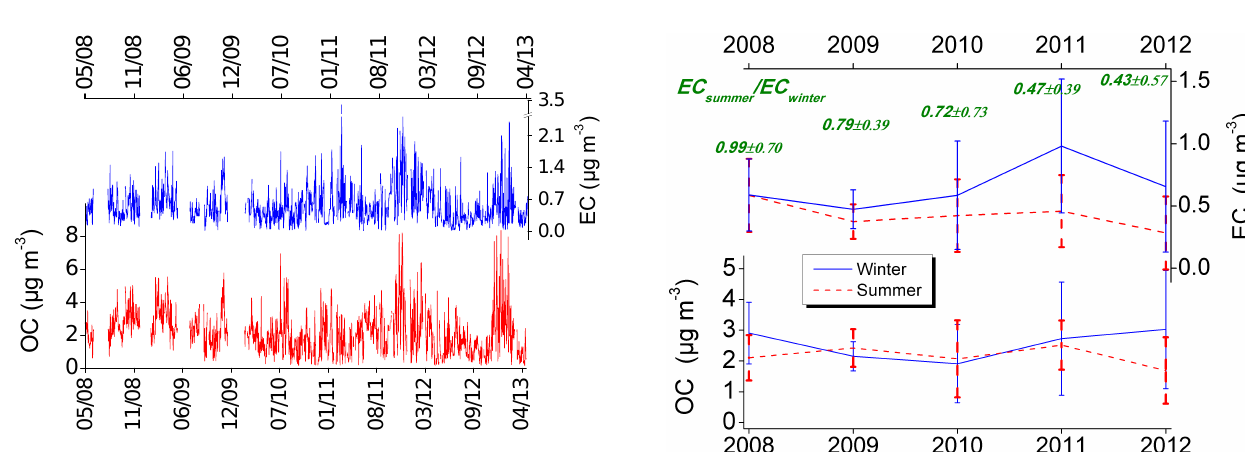
Figure 3. Average winter and summer OC and EC concentrations calculated from daily values and EC summer -to-EC winter median ra- tios for the period May 2008–April 2013.